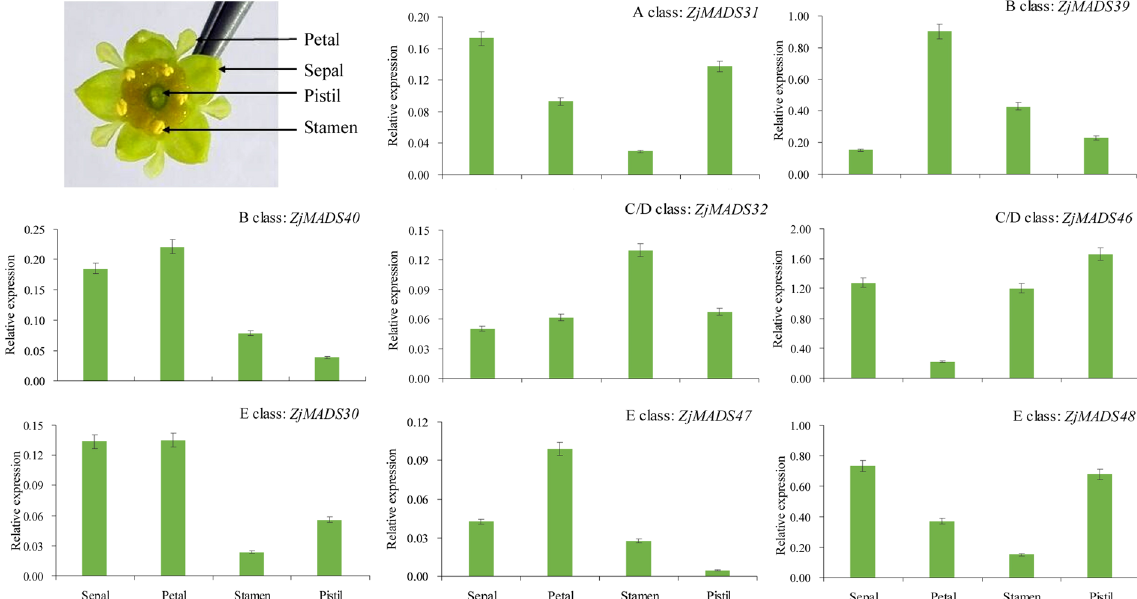
Figure 6. Expression patterns of 8 MIKC genes in four whorls of floral organs (sepal, petal, stamen and pistil) by RT-qPCR. ZjACT primers were used as the internal standard for each gene. The mean expression value was calculated from 3 independent replicates. The vertical bars indicate the standard